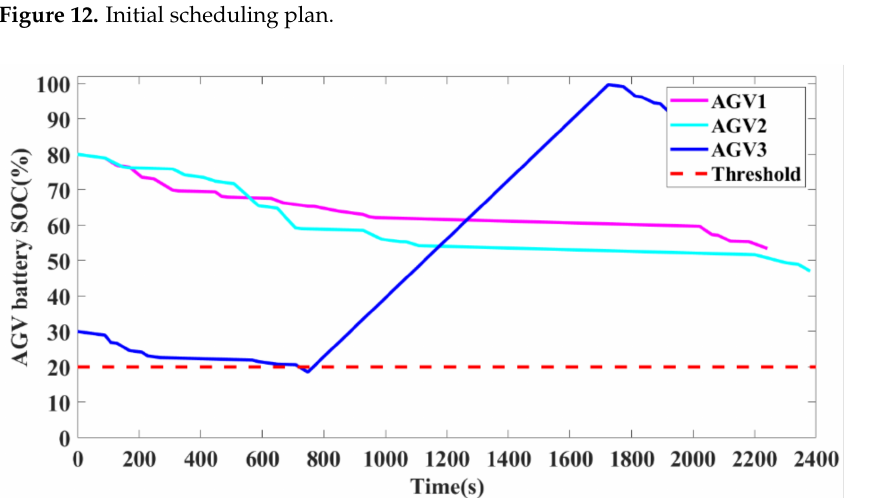
Figure 13. The predicted AGV SOC curve when the initial schedule is